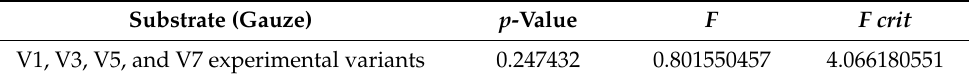
Table 4. A one-way ANOVA test for the polyphenols in Lepidium sativum L. sprouts’ weight. Substrate